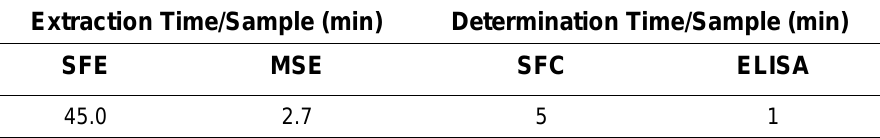
Overall Extraction and Determination Time by SFE, MSE, SFC, and ELISA Techniques of Each Food